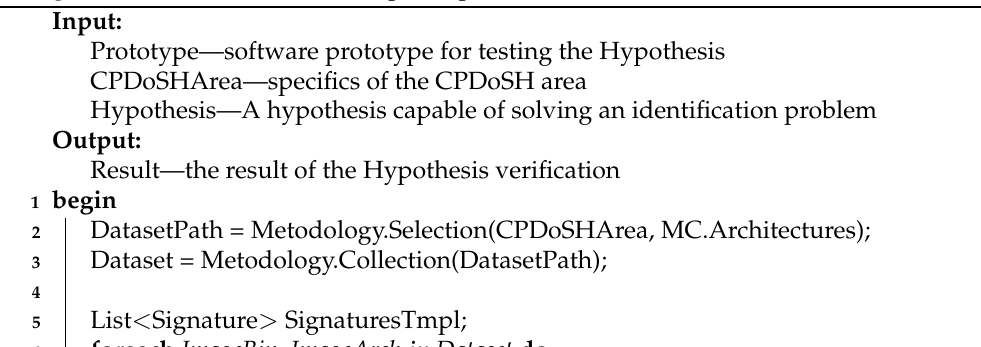
Algorithm 5: Pseudocode for Stage 5